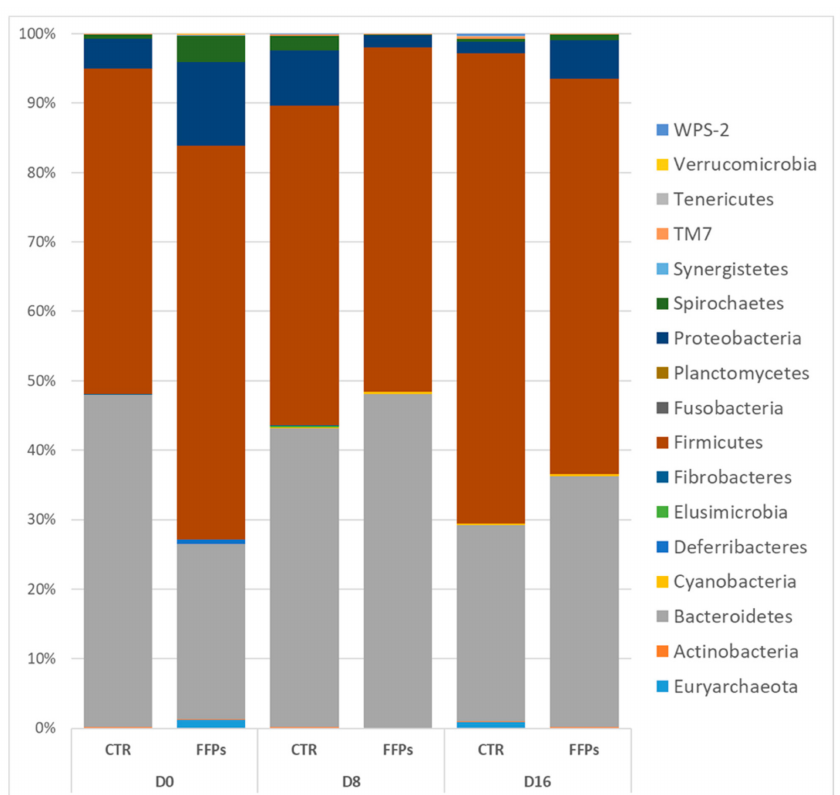
Figure 7. Classification of gene sequences at the phylum level for the control and FFP pigs at each sampling time.